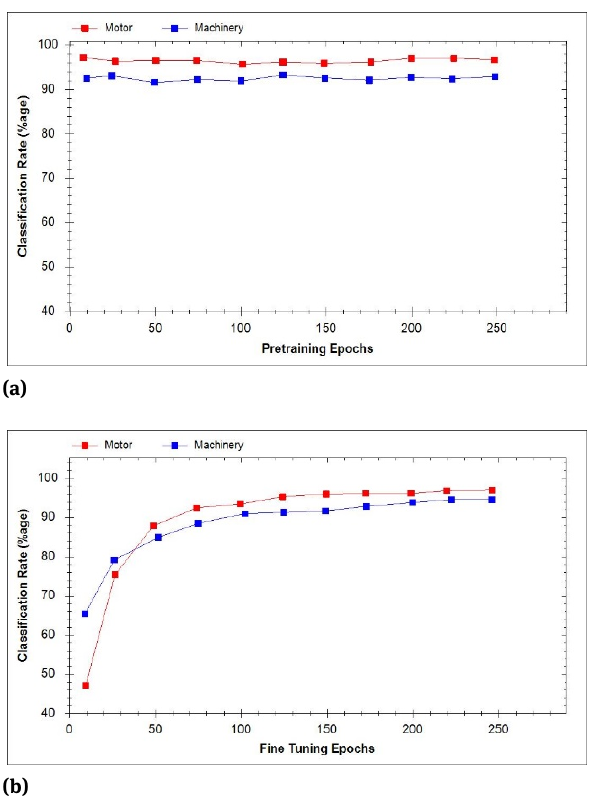
Figure 8: Relation among various epochs and classification rate: (a) classification rate and pretraining epochs; (b) classification rate and fine tuning epochs in time-frequency domain